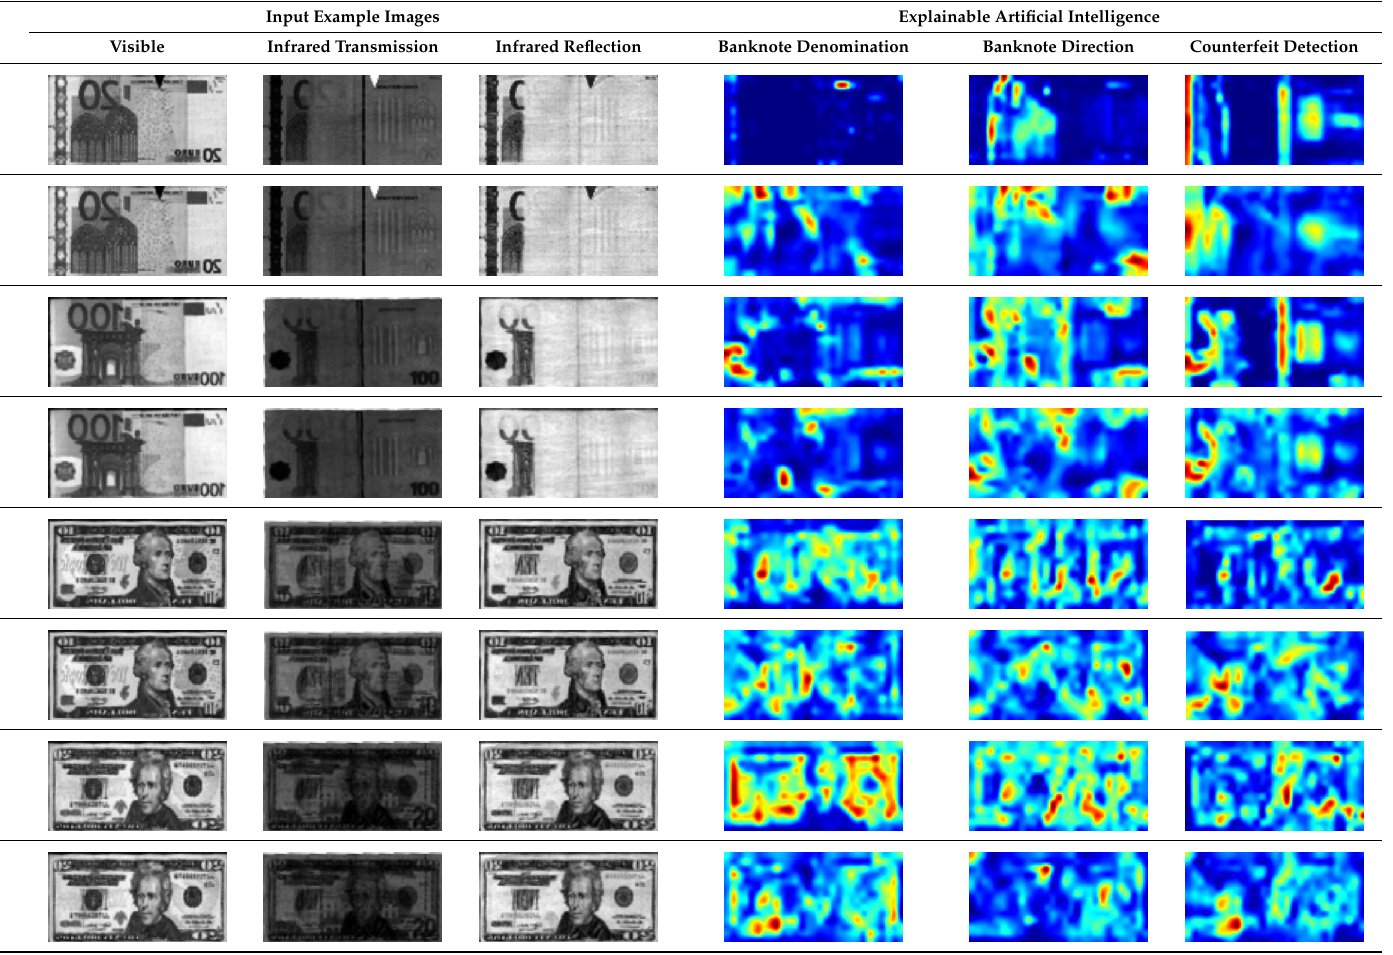
Table 6. Average Grad-CAM and pGrad-CAM